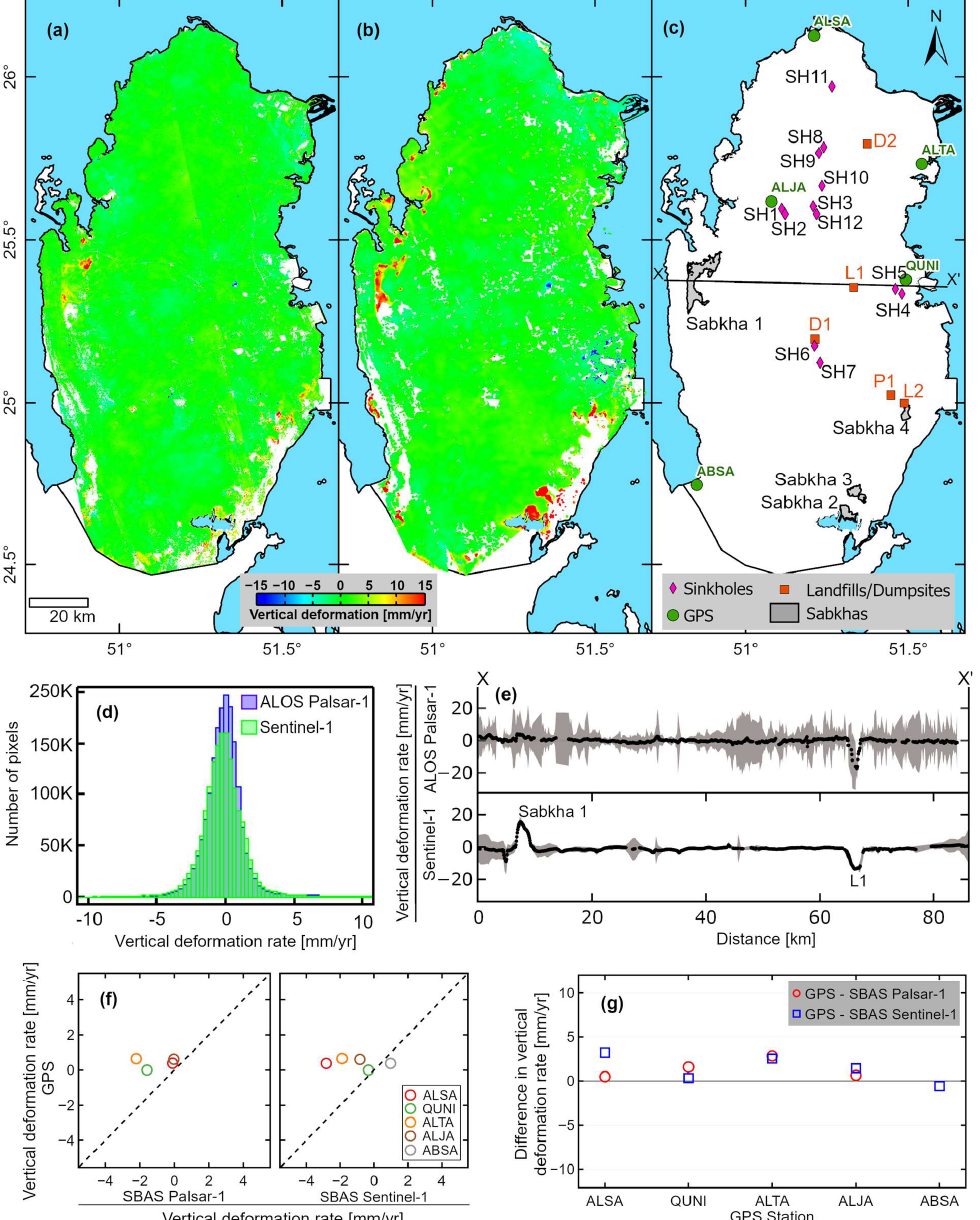
Figure 3. Correlation of the SBAS vertical deformation rate maps (mm/yr) with the known distribution of sabkhas, landfills, and sinkholes. ( a ) SBAS deformation map generated from ALOS Palsar-1 data. ( b ) SBAS deformation map generated from Sentinel-1 data. ( c ) Sketch map showing the distribution of sabkhas, landfills, dumpsites, and solid waste processing plant, and sinkholes. ( d ) Histograms for the ALOS Palsar-1 and Sentinel-1 of deformation rate maps. ( e ) Profiles of estimated deformation rate (black dots) and associated RMSE (grey shaded areas) along the transect XX’ plotted on Figure 3 c . ( f ) Comparison between GPS-derived vertical deformation rates with the vertical deformation rates calculated from ALOS Palsar-1 and Sentinel-1 datasets. ( g ) Difference between GPS- and SBAS- derived deformation rates. Abbreviations are defined in caption of Figure 1 c .